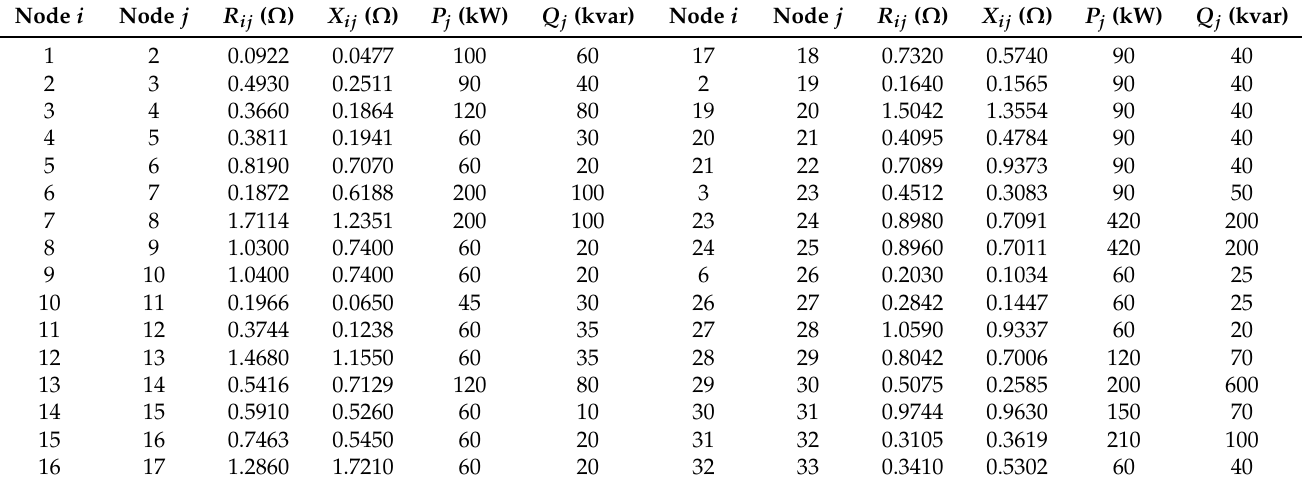
Table 1. Electrical parameters of the IEEE 33-node test feeder.